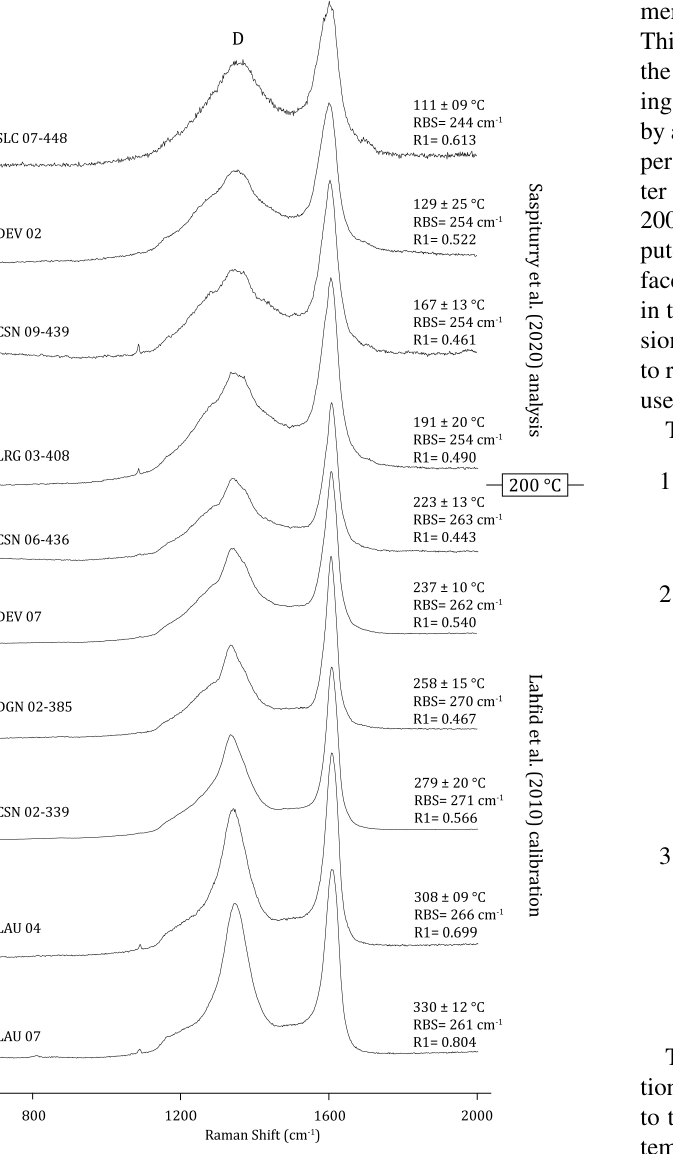
Figure 2. Representative Raman spectra of carbonaceous materi- als for a selection of samples from this study and the correspond- ing temperatures obtained using Lahfid et al. (2010) calibration and Saspiturry et al. (2020) quantitative analysis. The Raman band sep- aration (RBS) represents the distance between the D and G bands. R1 is the Raman parameter of the intensity ratio between the D band and the G band. See also the Supplement for details regarding the RBS and